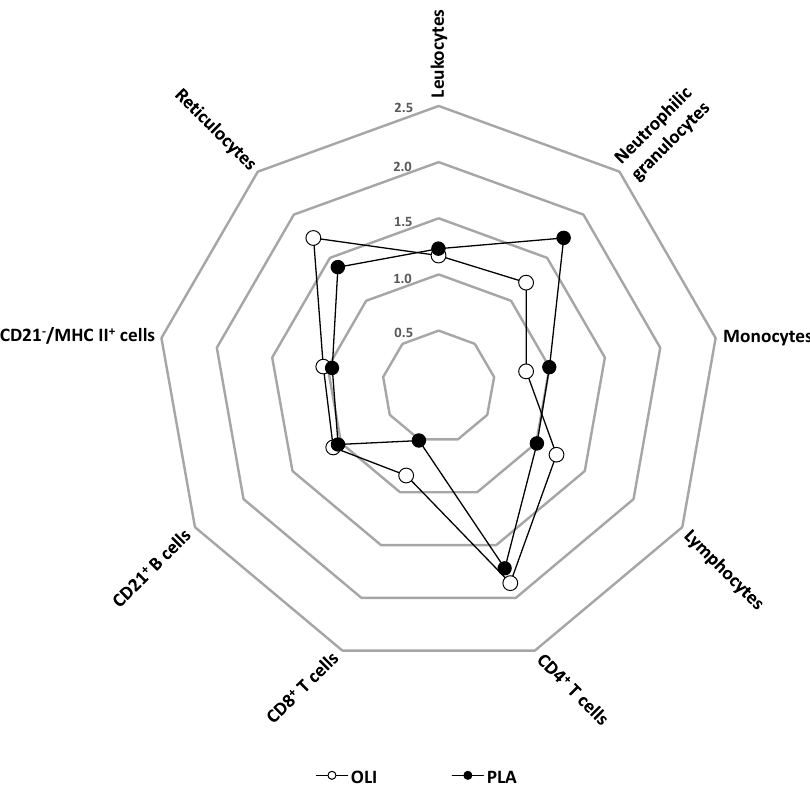
The observed changes in blood leukocyte and cell subpopulation numbers ranged between a 0.5-fold decrease (Figure 3, PLA, CD8 + T cells) and a 1.9-fold increase in CD4 + T-cells (Figure 3, OLI, CD4 + T cells).